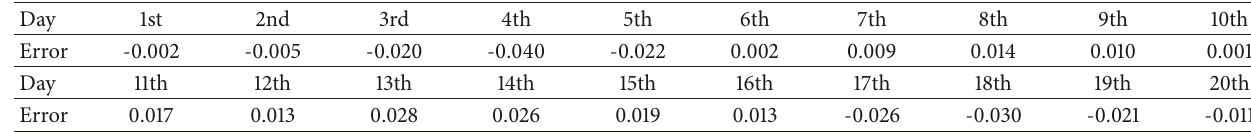
Table 2: Error caused by the superposition process.